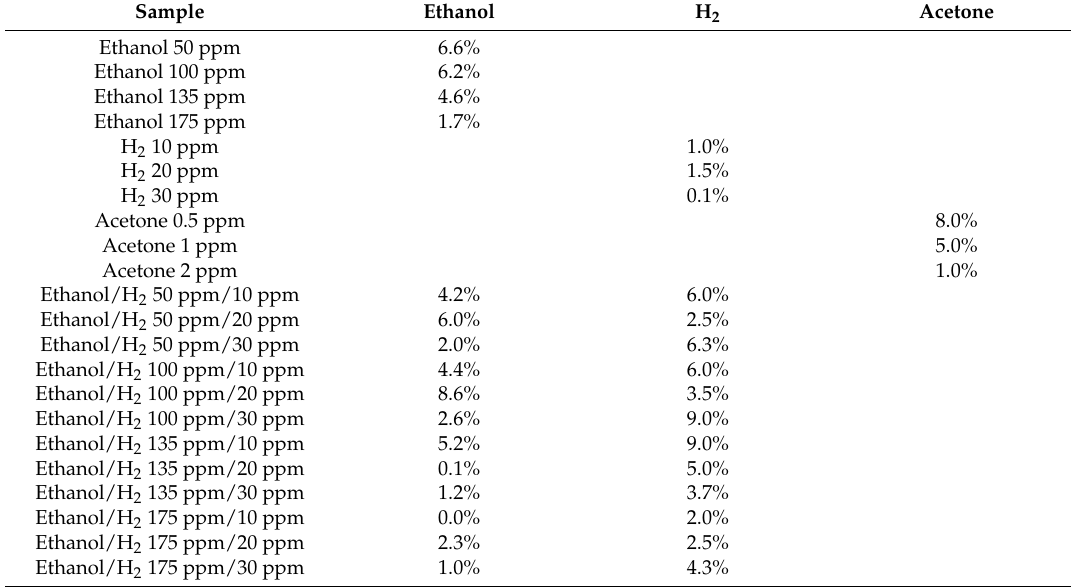
Table 4. Relative Analysis Errors between dosed concentrations and determined concentrations of the samples and the sample components, respectively, in